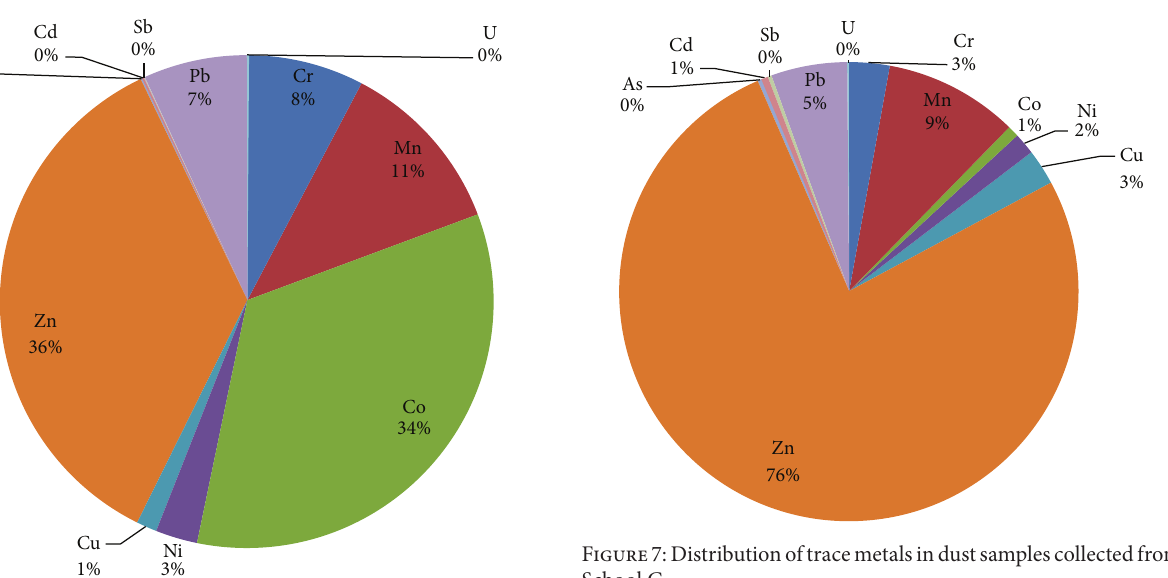
Figure5:Distributionoftracemetalsindustsamplescollectedfrom School E.